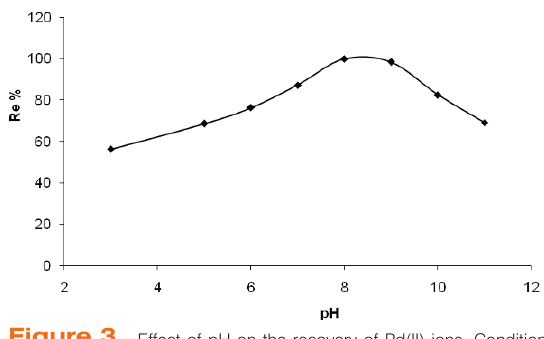
Figure 3. Effect of pH on the recovery of Pd(II) ions. Conditions: Pd(II), 5.0 m g; flow rate of sample and eluent, 3.0 and